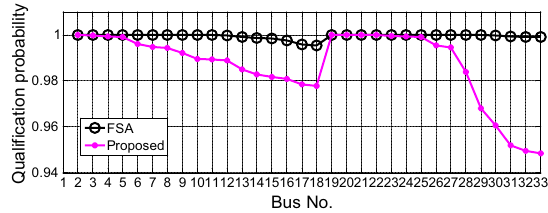
Fig. 13 Bus voltage qualification probabilities for different methods